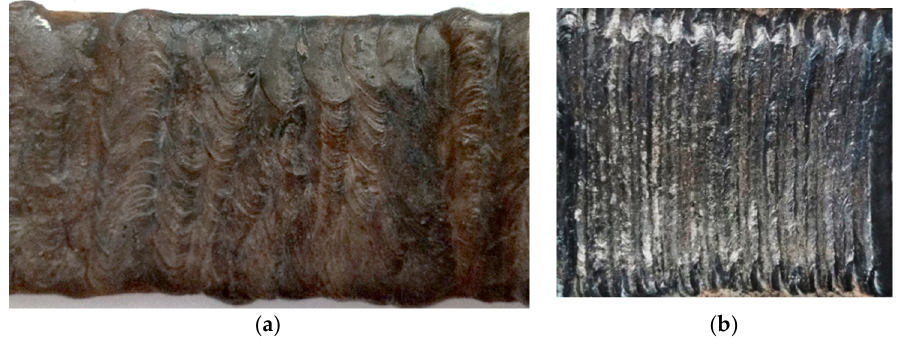
Figure 5. Sample with hardfacing materials; ( a ) OK 84.58; and ( b ) UTP 690.